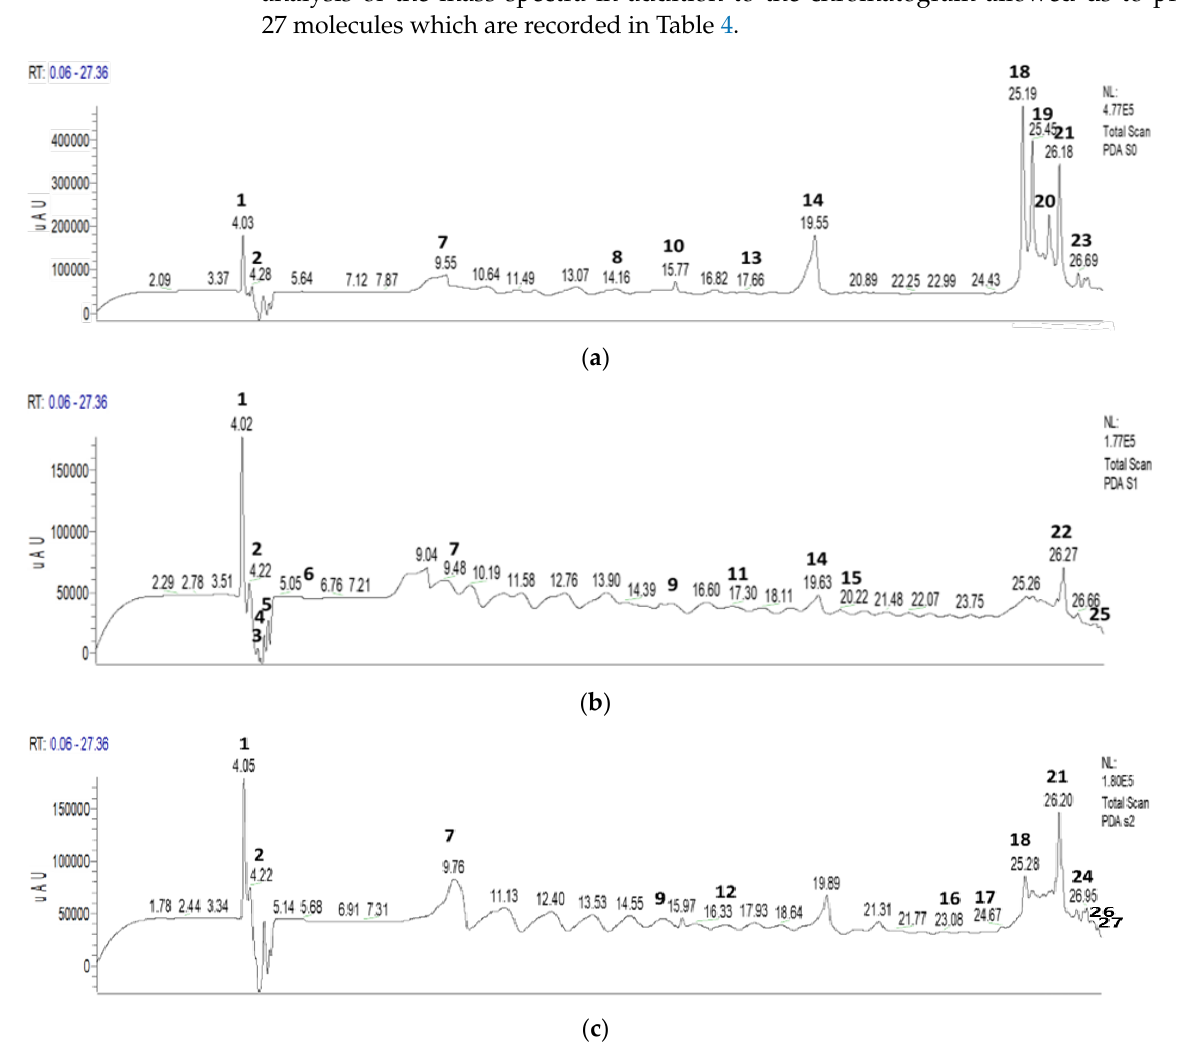
Figure 5. HPLC chromatograms of C. sativus compounds: ( a ) decocted; ( b ) aqueous extract obtained by Soxhlet extraction; ( c ) hydroethanolic extract obtained by Soxhlet extraction.